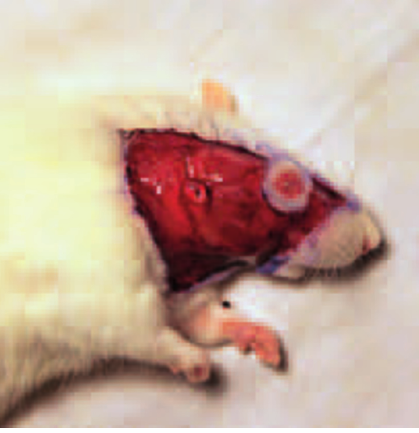
Figure 5. Excision of a fl ap in recipient similar to the donor fl